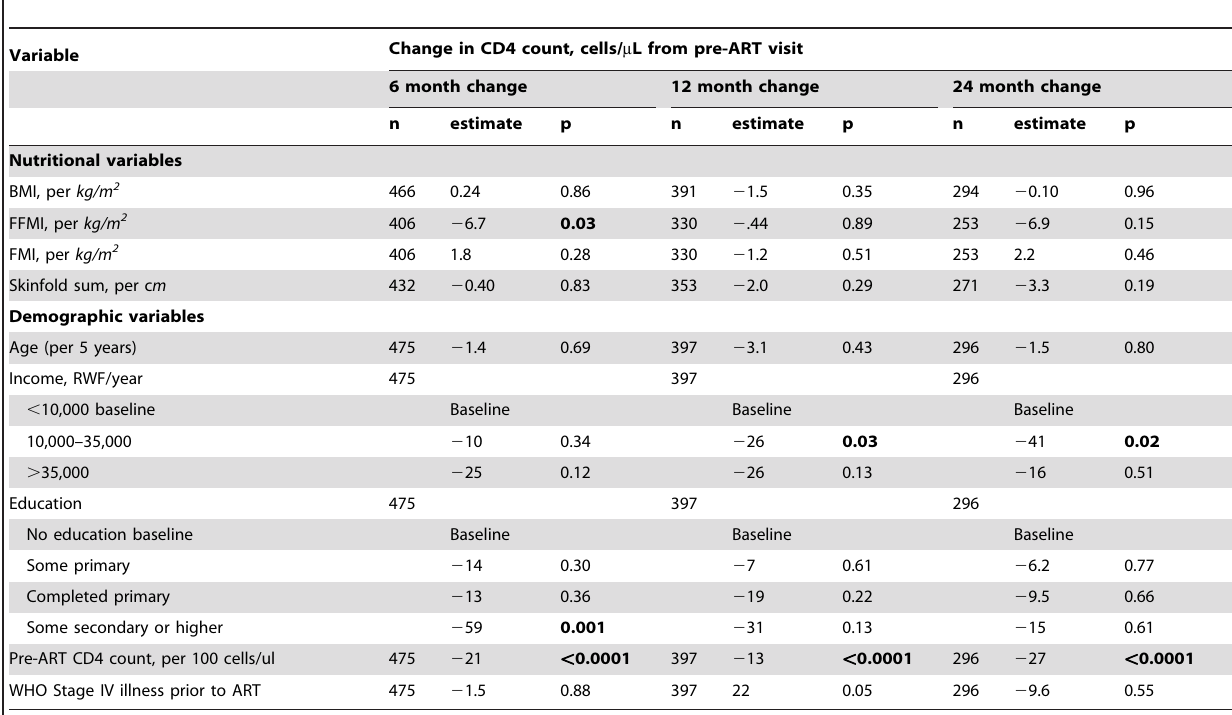
Table 2. Univariate variables and Change in CD4 count at 6, 12, and 24 months from pre-ART visit.